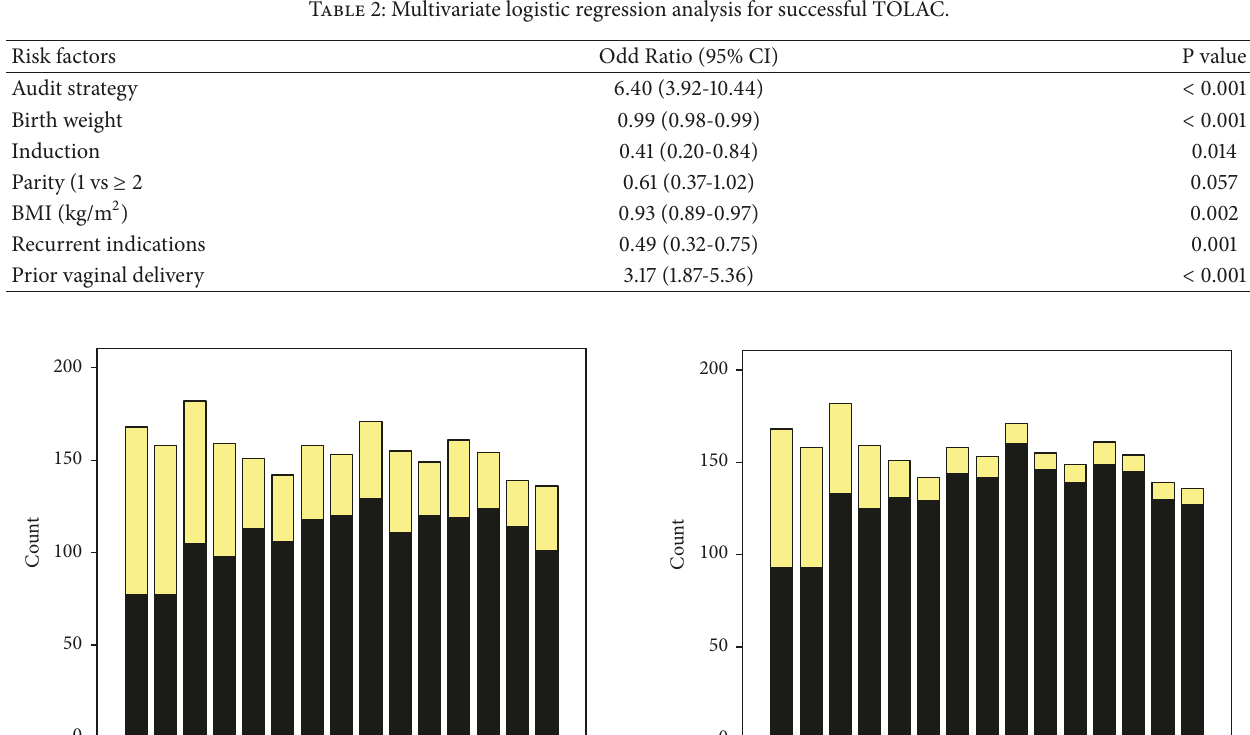
Table 2: Multivariate logistic regression analysis for successful TOLAC.